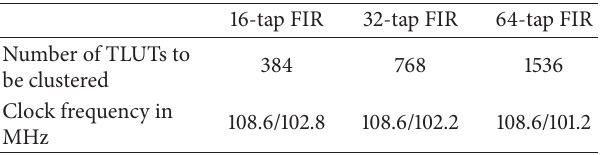
Table 8: Maximum clock the design can support on the